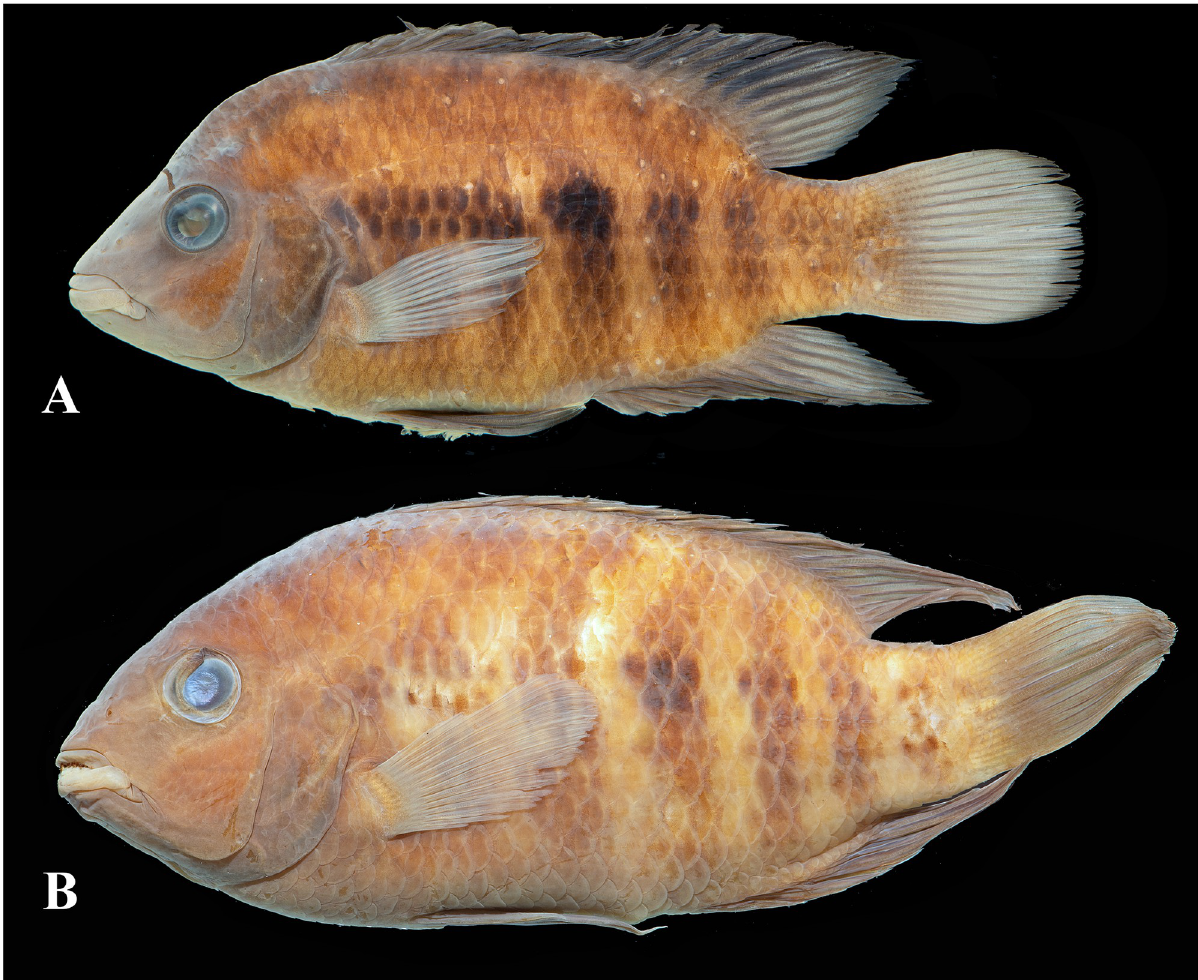
Fig 28. A. Australoheros ricani , holotype adult female, 75.5 mm SL; UFRGS 28500; Brazil: Rio Grande do Sul, Rio Jacuı´drainage: Espumoso: Rio Morcego, tributary of the Rio Jaquı´-mirim. B. Australoheros cf. ricani , “Jacuı´”, adult female, 105.2 mm SL; MZUSP 30411; Brazil:_Rio Grande do Sul: Marau: Rio Jacuı´drainage: Arroio Tr ê s Passos, tributary of the Rio